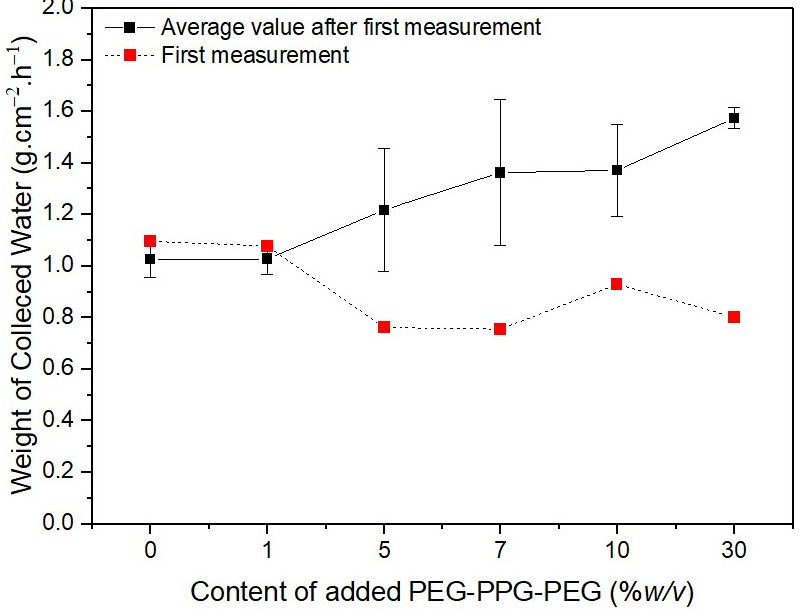
Figure 9. Weight of water collected over 6 min depending on the PEG-PPG-PEG content of the samples.